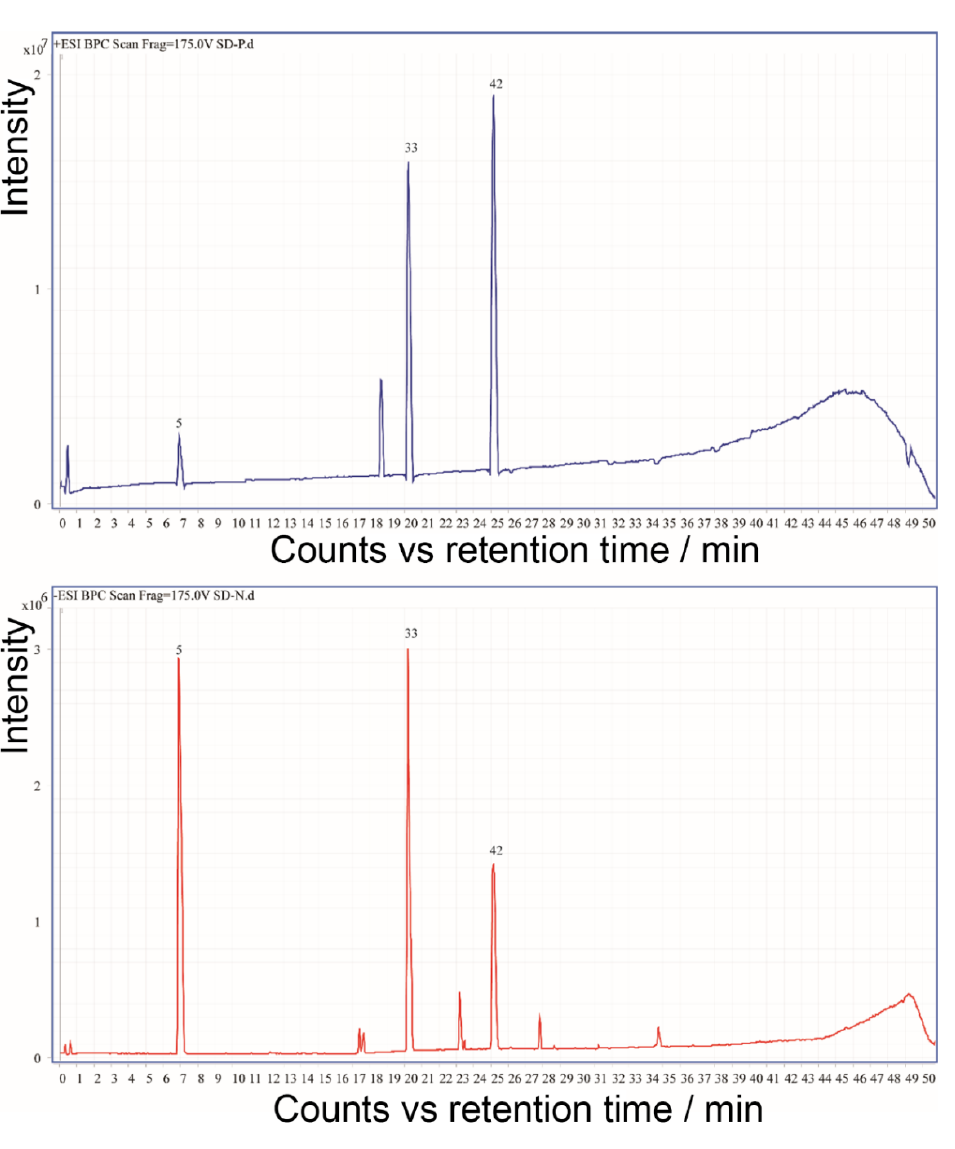
Figure 3. The base peak chromatograms (BPC) in positive negative and positive modes of the 3 standards of Zingiber officinale Rosc.: 5 zingerone, 33 6-gingerol, and 42